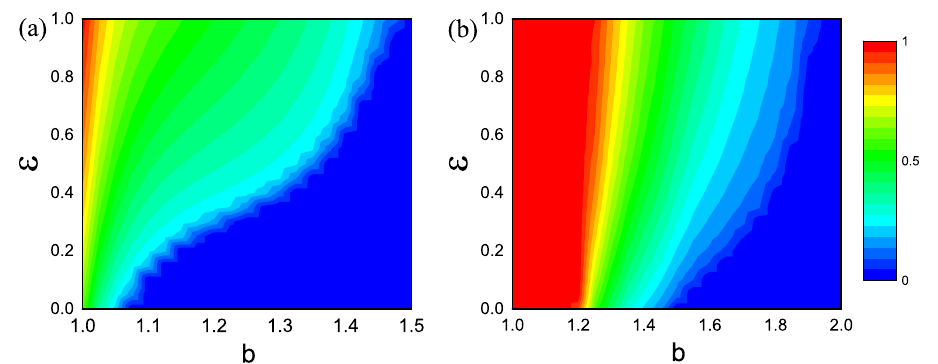
Fig 7. Contour plots for the fraction of cooperators F C on the ε − b parameter plane for different topologies with the average degree h k i = 4. (a) is for random regular networks and (b) is for ER networks. Simulations are carried out for the network size N =